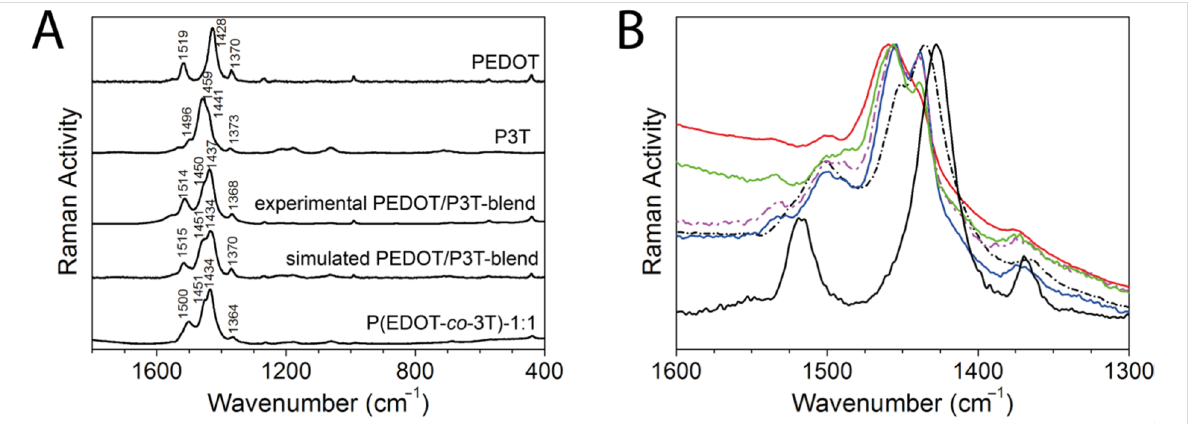
Figure 2: A: Raman spectra of electrodeposited films of the homopolymer P3T and PEDOT, PEDOT/P3T-blend, a simulated spectrum of a blend of PEDOT and P3T (created by adding the spectra of the two homopolymers) and the copolymer P(EDOT- co -3T)-1:1, λ exc = 532 nm. B: Comparison of Raman spectra between 1300 and 1600 cm − 1 for different monomer ratios of the copolymer films (black curve EDOT, broken black curve 1:1, blue 1:3, broken pink curve 1:5, green curve 1:10, red curve P3T), λ exc = 532